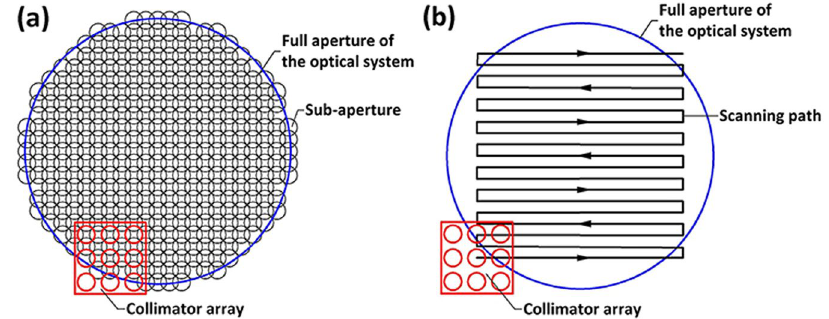
Figure 2. ( a ) Sub-aperture arrangement, ( b ) scanning path for the multi-beam